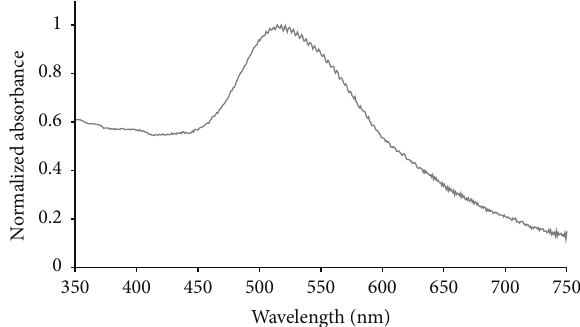
Figure 1: Absorbance spectrum of a 0.5 𝜇 M AuNP suspension. The peak at 515 nm corresponds to an average nanoparticle diameter of approximately 10nm.